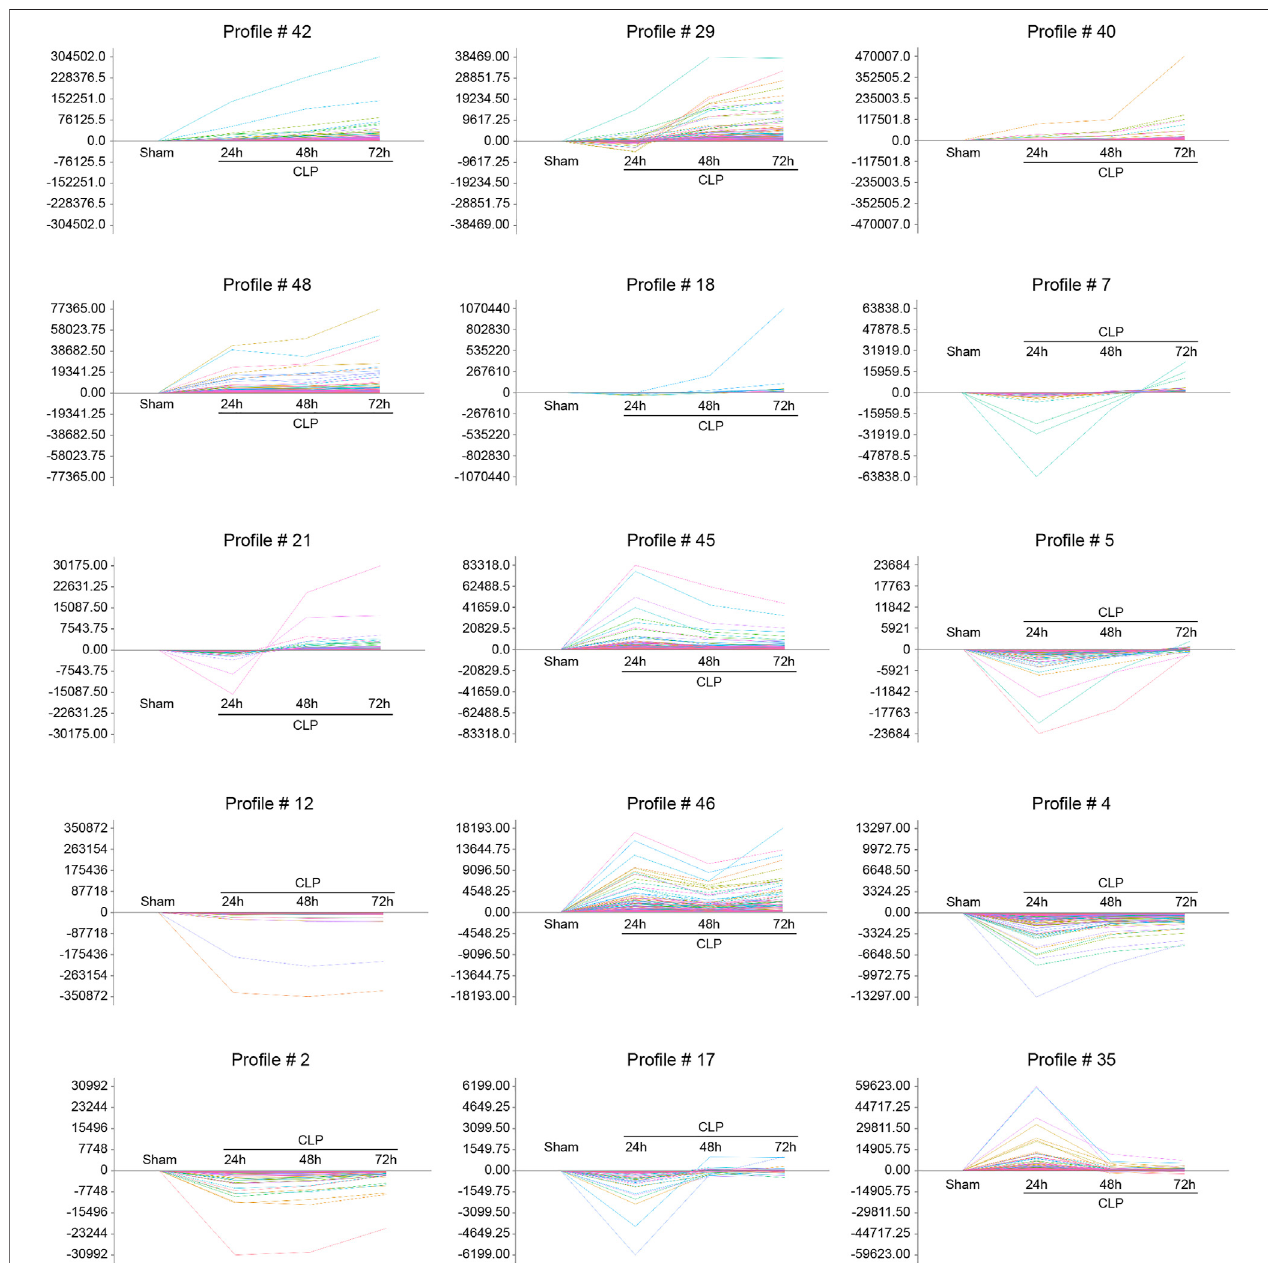
FIGURE 4 | The time-series analysis of co-expressed DEGs during sepsis-induced cardiac injury. Mice were subjected to CLP for 24, 48, and 72 h (n = 5 per group). Gene expression trend analysis was utilized to identify the gene expression patterns of DEGs in 15 pro fi les (No. 42, 29, 40, 48, 18, 7, 21, 45, 5, 12, 46, 4, 2, 17, and 35) in the heart after CLP surgery at different time points. The vertical axis represents the gene expression levels, and the horizontal axis demonstrates the time points.